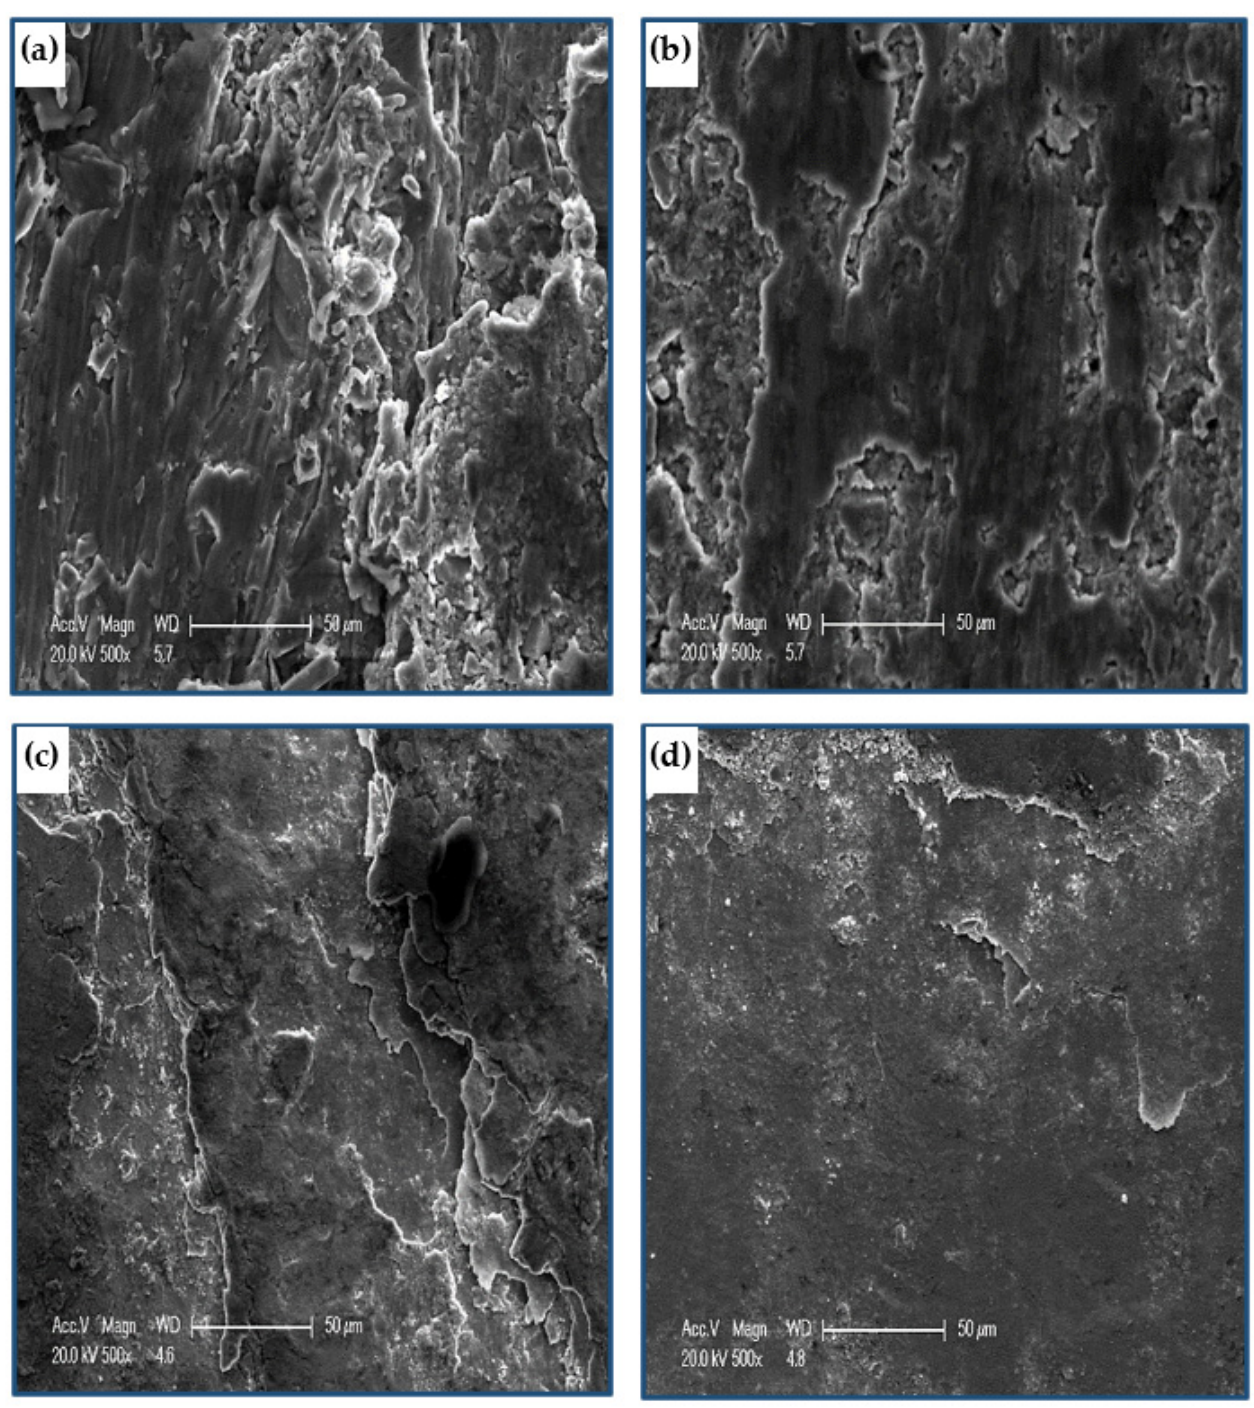
Figure 11. Worn surface morphology of Cu ( a ) annealed, ( b ) 1 pass, ( c ) 2 passes, ( d ) 4 passes under a sliding distance of 1375.2 m, and an applied load of 50 N.